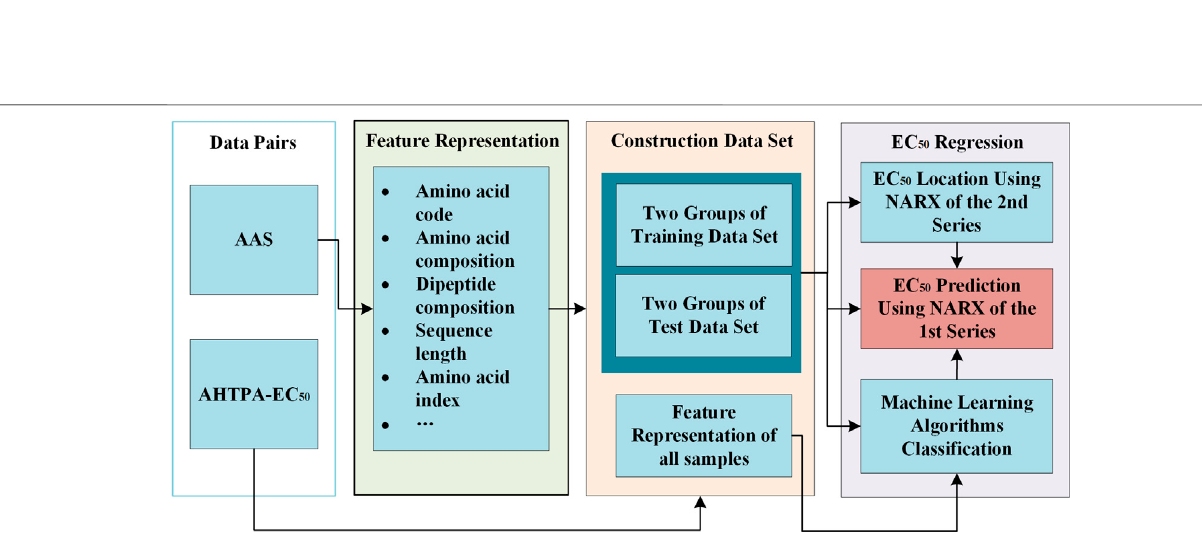
FIGURE 10 | Prediction method for AHTPA-EC 50 – based